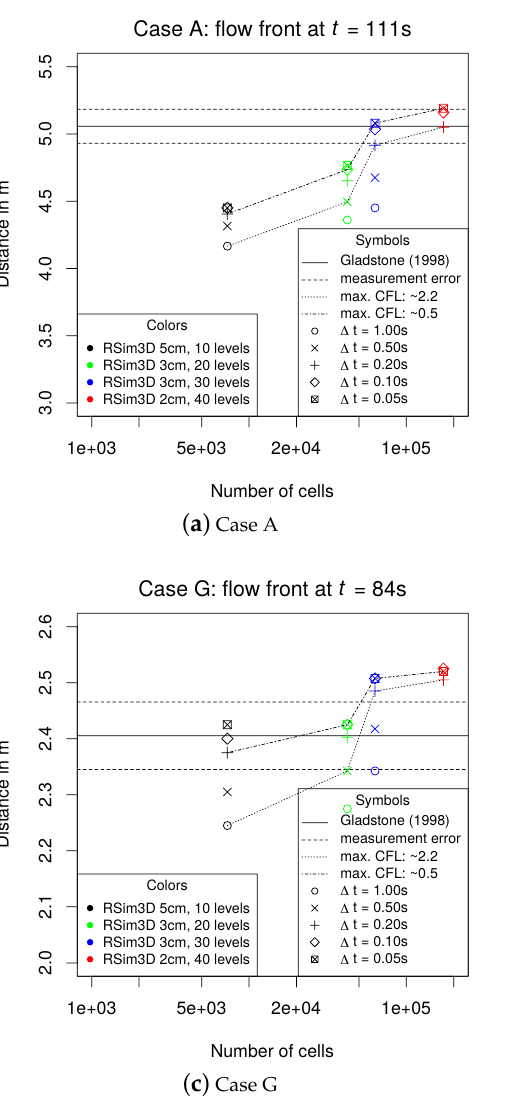
Figure 10. Mesh convergence of the numerical models of lock exchange experiments. The cases differ in their composition of particle sizes in the suspension: ( a ) Case A d = 25µm. ( b ) Case D d 1 = 25µm, d 2 = 69µm. ( c ) Case G d = 69µm. ( d ) Case R d 1 = 17µm, d 2 = 37µm, d 3 = 63µm, d 4 = 88µm, d 5 = 105µm. In cases including more than one grain size the total sediment concentration is uniformly distributed across all